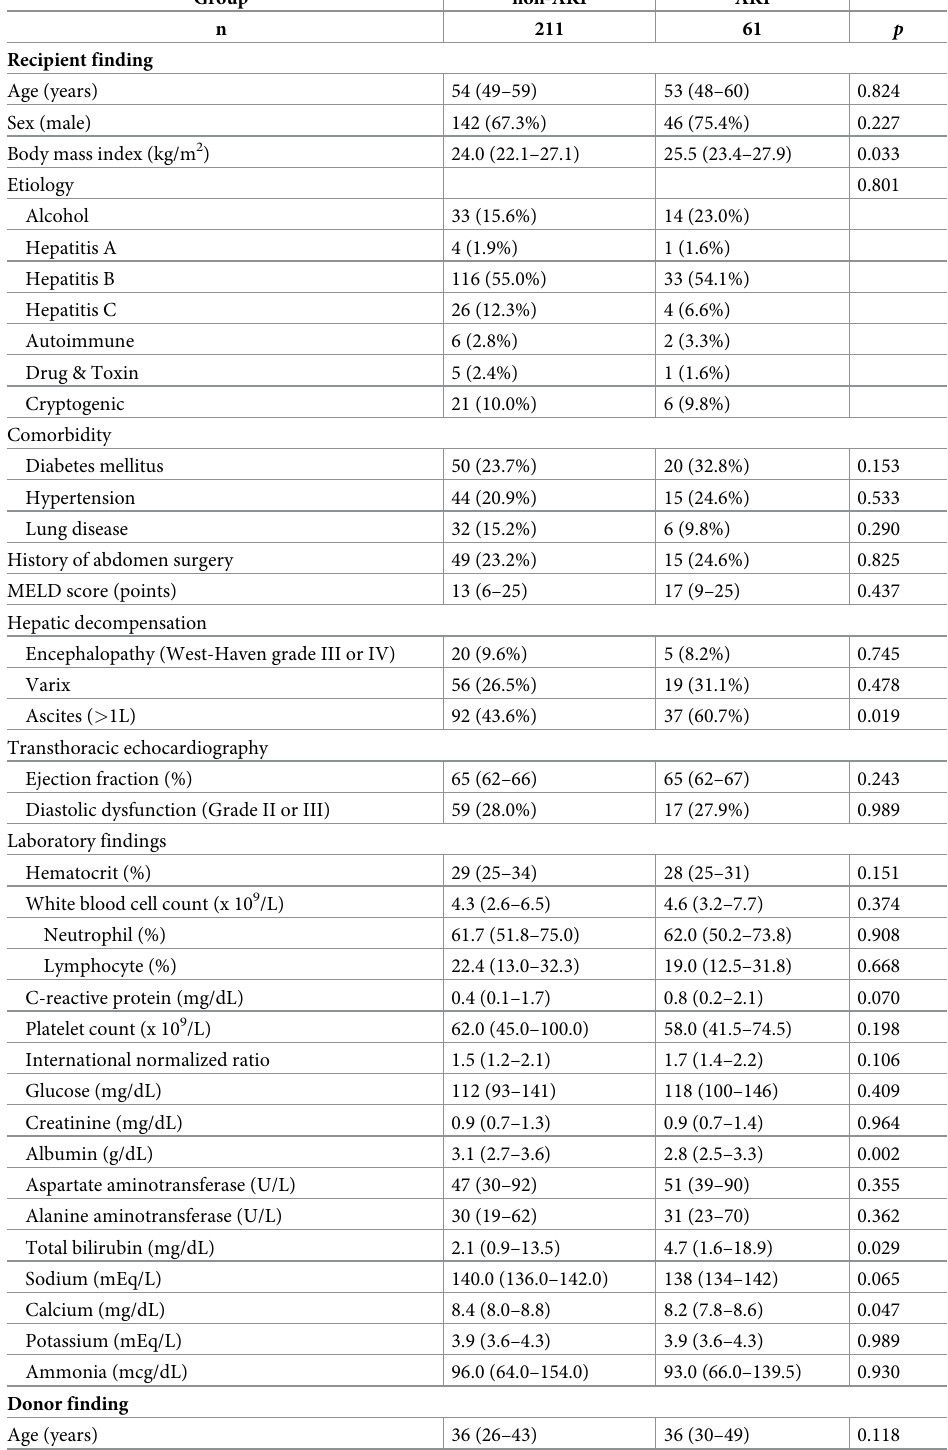
Table 1. Comparisons of preoperative recipient and donor findings between non-AKI and AKI groups in patients undergoing living donor liver